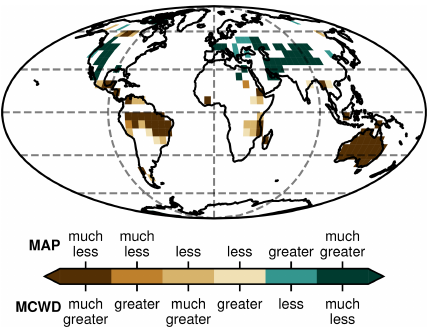
Figure 9. Map of grid points where the PEN scenario had the largest differences in terms of both MAP and MCWD, with respect to the CTL simulation. Grid lines are spaced every 30 ◦ from the Equator and 90 ◦ from Greenwich, in latitude and longitude, respec-